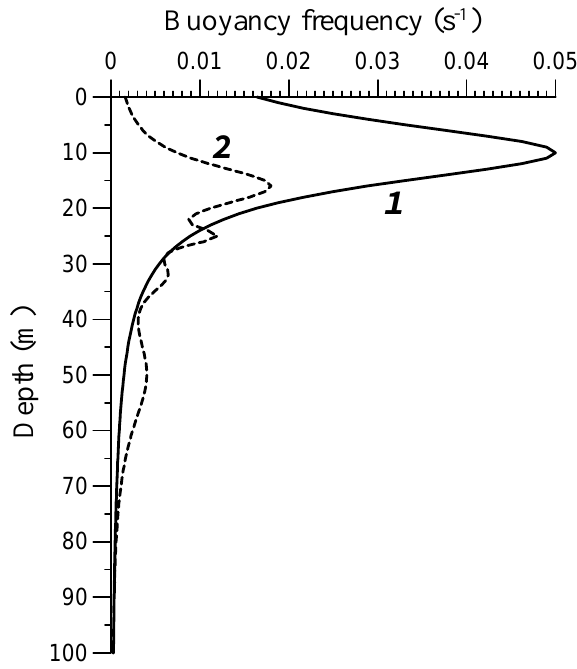
Fig. 3. Buoyancy frequency profiles measured in Lake Constance during summer (1) and in autumn (2) (Ollinger,